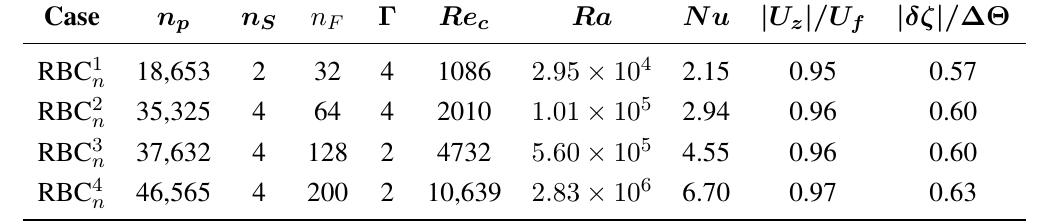
, the number of p . F